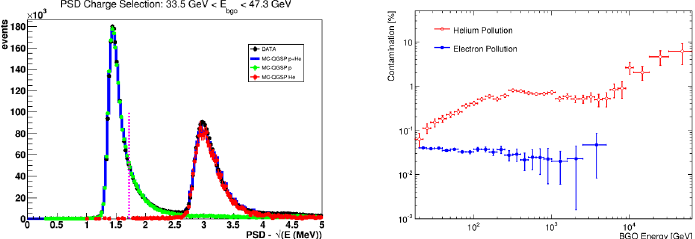
Figure 3. Left - The combined charge spectrum of PSD for protons and helium nuclei, for BGO energies be- tween 33.5 GeV and 47.3 GeV. In this plot there are the on-orbit data (black), with the best fit templates of MC protons (green), helium nuclei (red) and their sum (blue). The vertical line shows the cut applied to select proton canditates. Right - The fraction of helium background (red) and electron background (blue) in proton candidate events as a function of BGO energy.